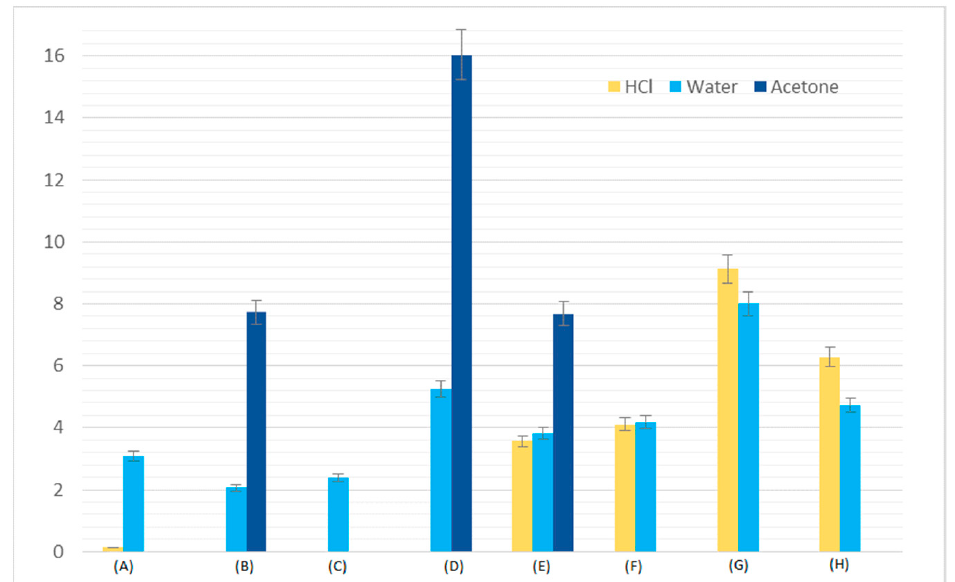
Figure 12. Swelling charts. ( A ) BPA + MMA, ( B ) BPA + MMA +1 %PC, ( C ) BPA + MMA + 5%PC, ( D ) BPA + MMA + 10%PC, ( E ) EGDMA + MMA, ( F ) EGDMA + MMA + 1%PC, ( G ) EGDMA + MMA + 5%PC, ( H ) EGDMA + MMA + 10%PC.